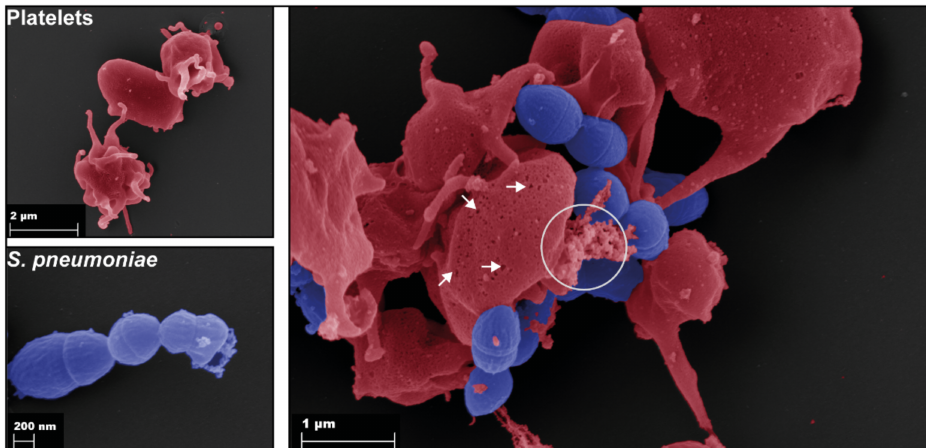
Figure 2. Binding of S. pneumoniae (blue) to platelets (red). Scanning electron microscopy of single platelets (upper left), single pneumococci (bottom left), and platelets incubated with the pneumococcal TIGR4 strain for 1 h (right). The right image shows binding of pneumococci to platelets. In addition, pneumolysin pores are formed in platelet membranes (arrows), and released granule content is visible